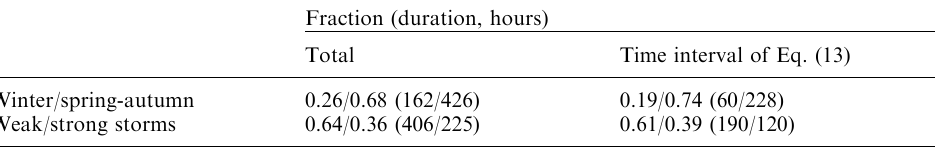
Fraction (duration, hours) Total Time interval of Eq.